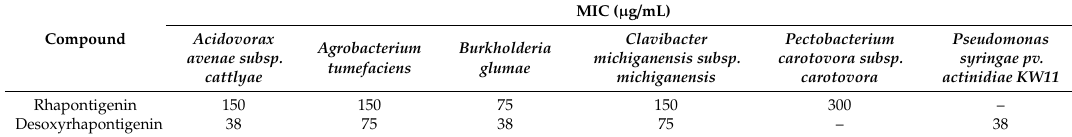
Table 3. MIC of stilbenoids against phytopathogenic microorganisms from Pham et al. (2017) [41]. Compound